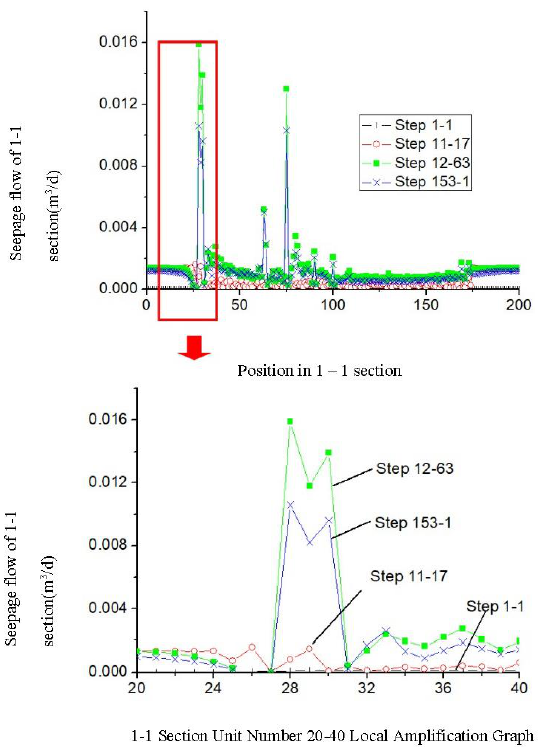
Figure 11. Numerical time distribution sequence of AE positioning in the specimen loading process.